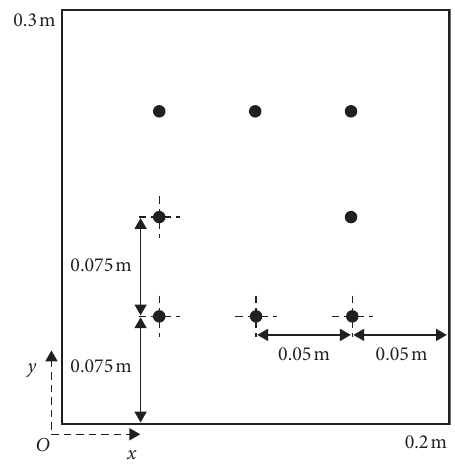
Figure 10: The arrangement of the VAS on the surface of the active MPPA.